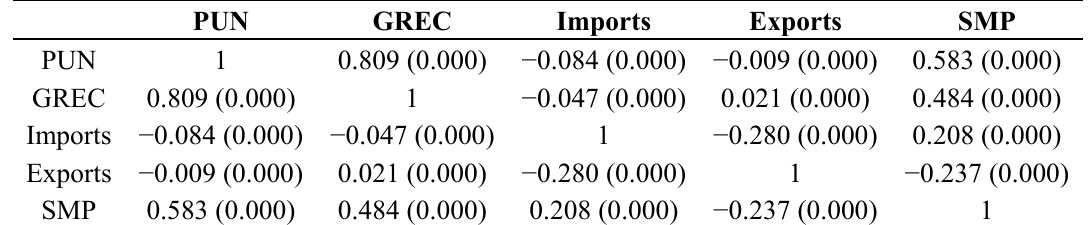
Table 3. Correlation Matrix (hourly data